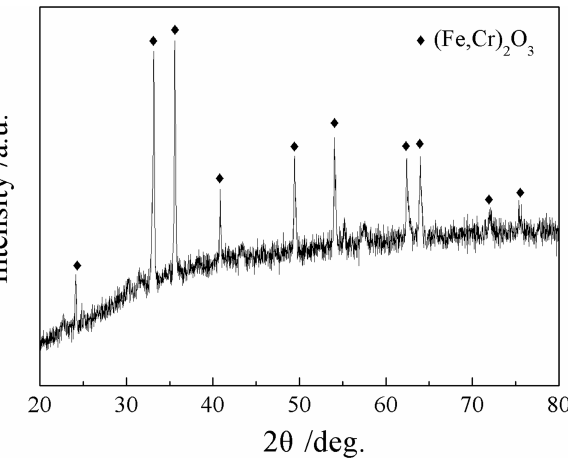
Figure 8: XRD pattern of the oxidized coating prepared under arc power of 35